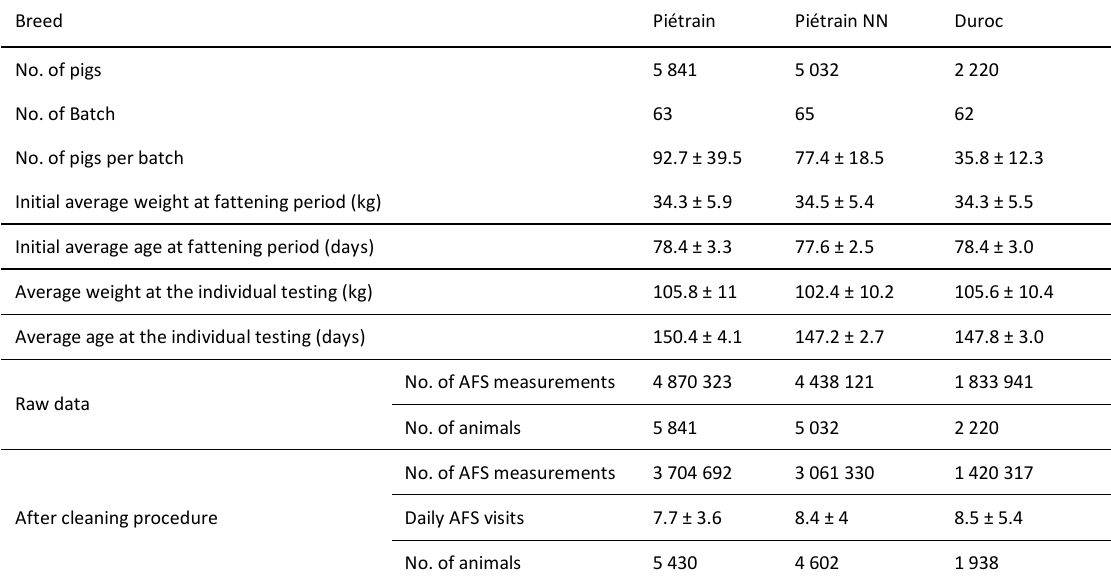
Table 1 . Descriptive statistics for the datasets used in this study